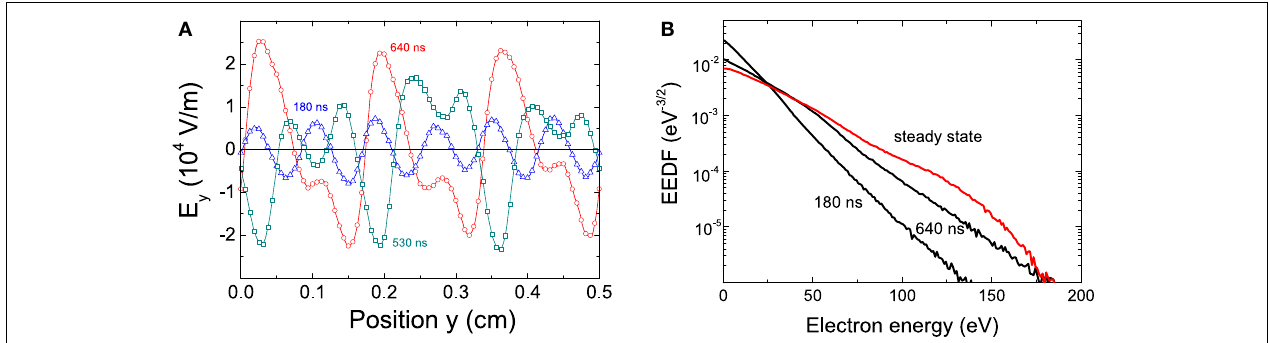
FIGURE 14 | (A) Distribution of the azimuthal wave electric field at different times before the steady state of Figure 13A is reached (same conditions as Figure 13 ); (B) electron energy distribution function (EEDF) at three different times in the same conditions.